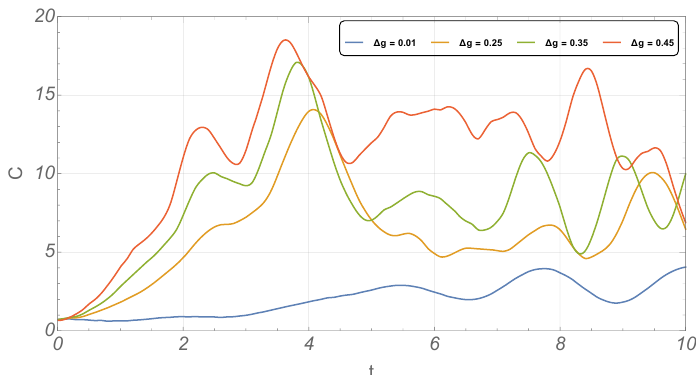
Figure 1: The time development of the commutator squared value shown for different quench amplitudes.